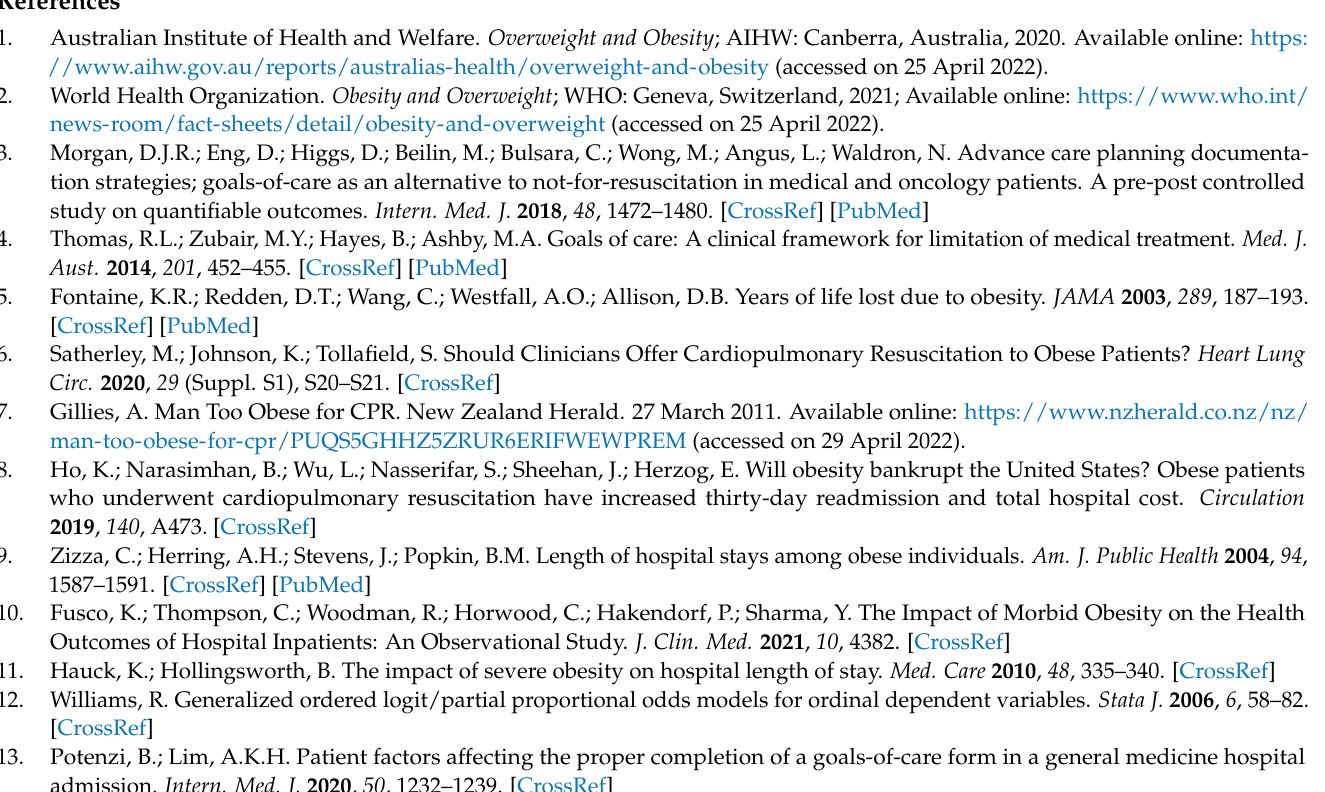
Table S1: Univariable logistic regression models. Table S2: Detailed multivariable regression model with testing of proportional odds